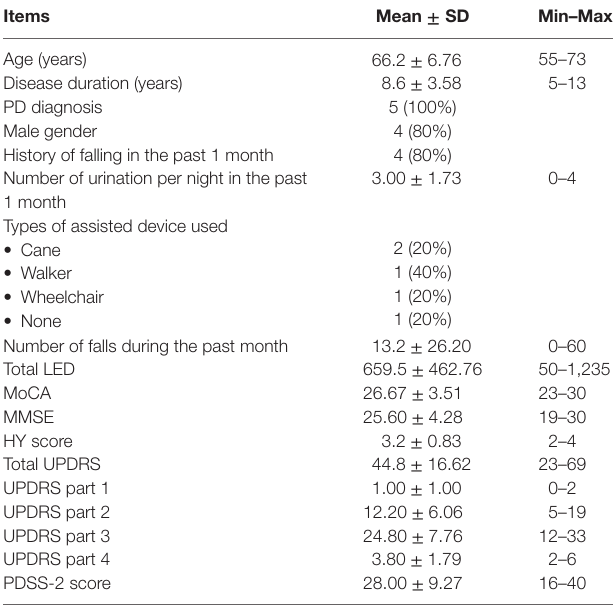
TaBle 1 | Demographic data of five Parkinson’s disease (PD)